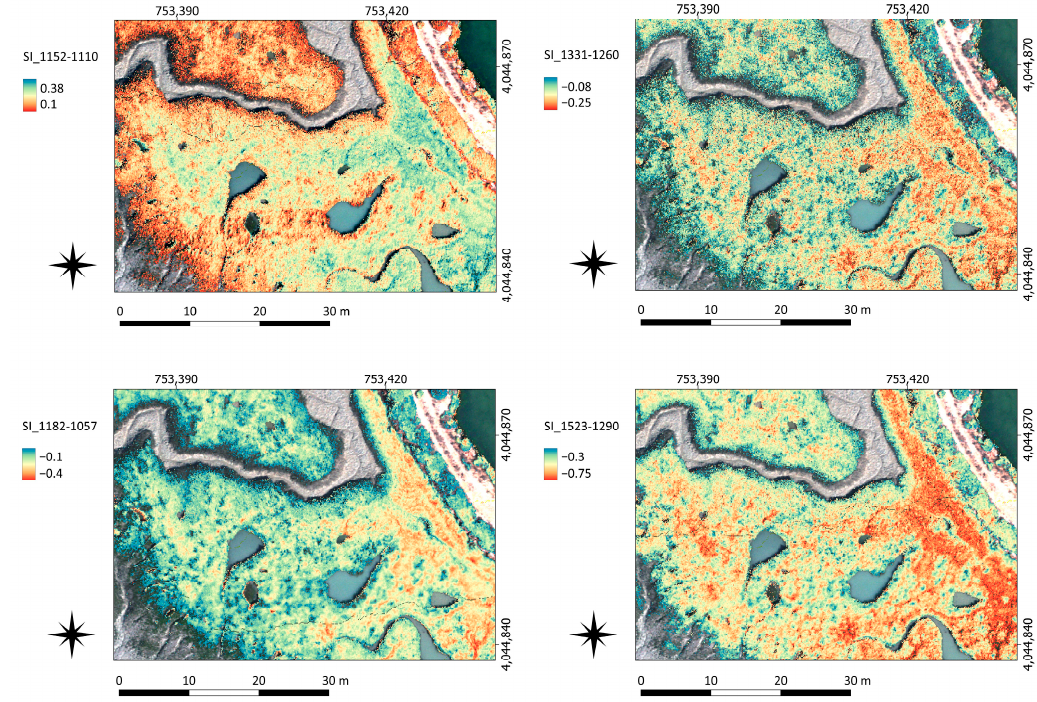
Figure 6. Distribution of spectral indices (SI) values in the salt marsh of Cadiz Bay. The results display only a detail of the study area, and the corresponding SI is indicated in the legend. Wavelengths used for creating SI are suitable to show the variations in canopy cover. Thresholds are adjusted for each index to better enhance differences in canopy cover.